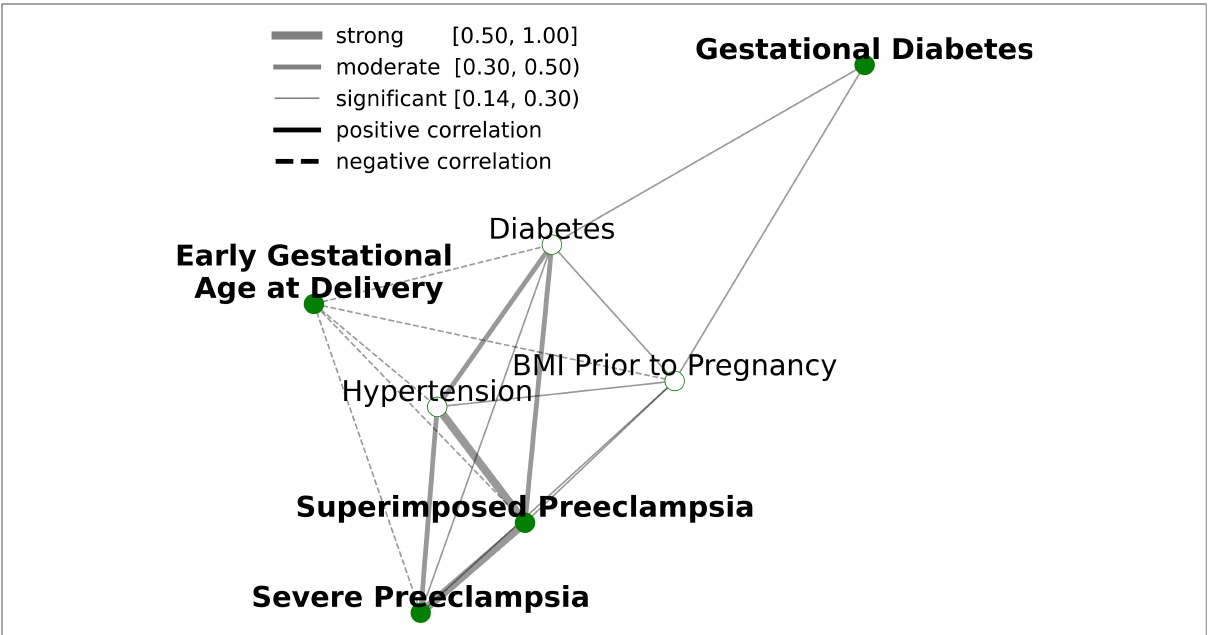
FIGURE 2 Relationships between APORFs during the fi rst trimester. Green nodes represent APOs while white nodes represent RFs present before conception. Edges represent the strength of the Spearman correlation between two outcomes, with green representing strong, orange representing moderate, and grey representing weak correlations, as de fi ned in Akoglu 2018. “ Pree ” is short for preeclampsia. APORFs are strongly correlated with one another, laying the foundation to jointly model these outcomes in a MML setting for improved predictive